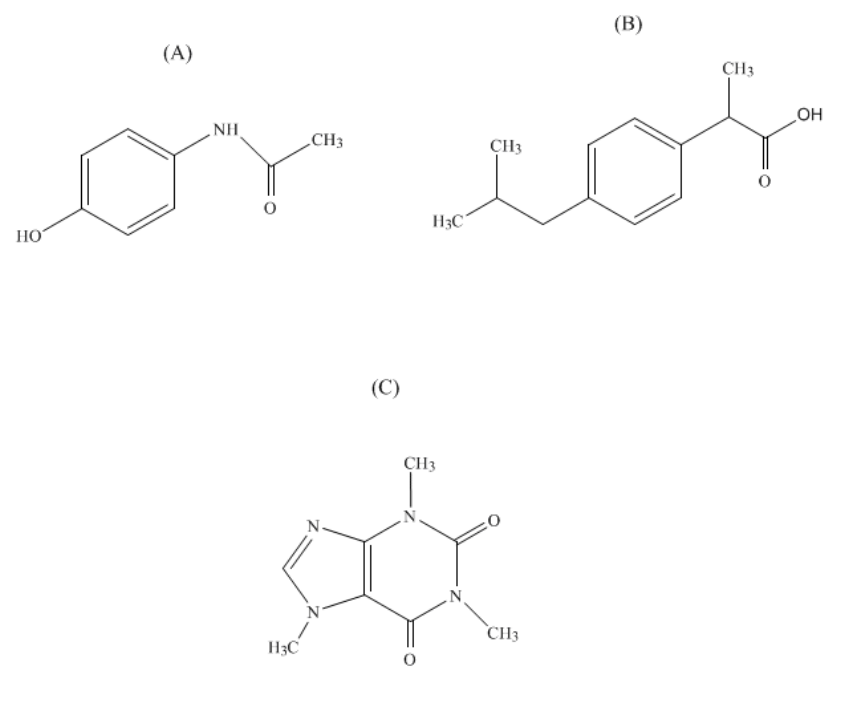
Figure 1: Chemical structures of paracetamol (A), ibuprofen (B) and caffeine (C).